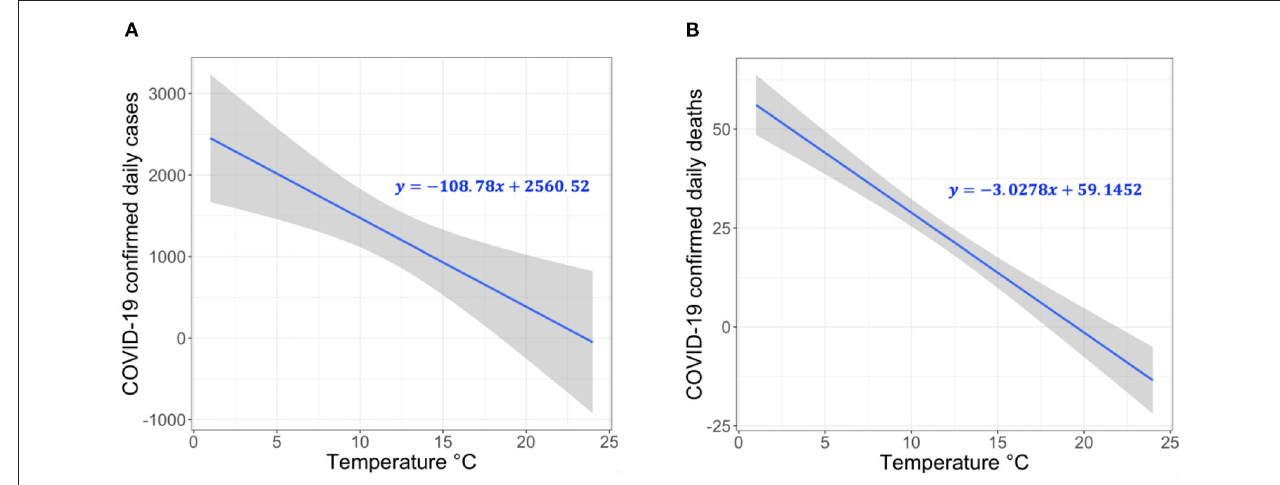
FIGURE 2 | Correlation between temperature and COVID-19 confirmed (A) case count and (B) death count in 26 cantons of